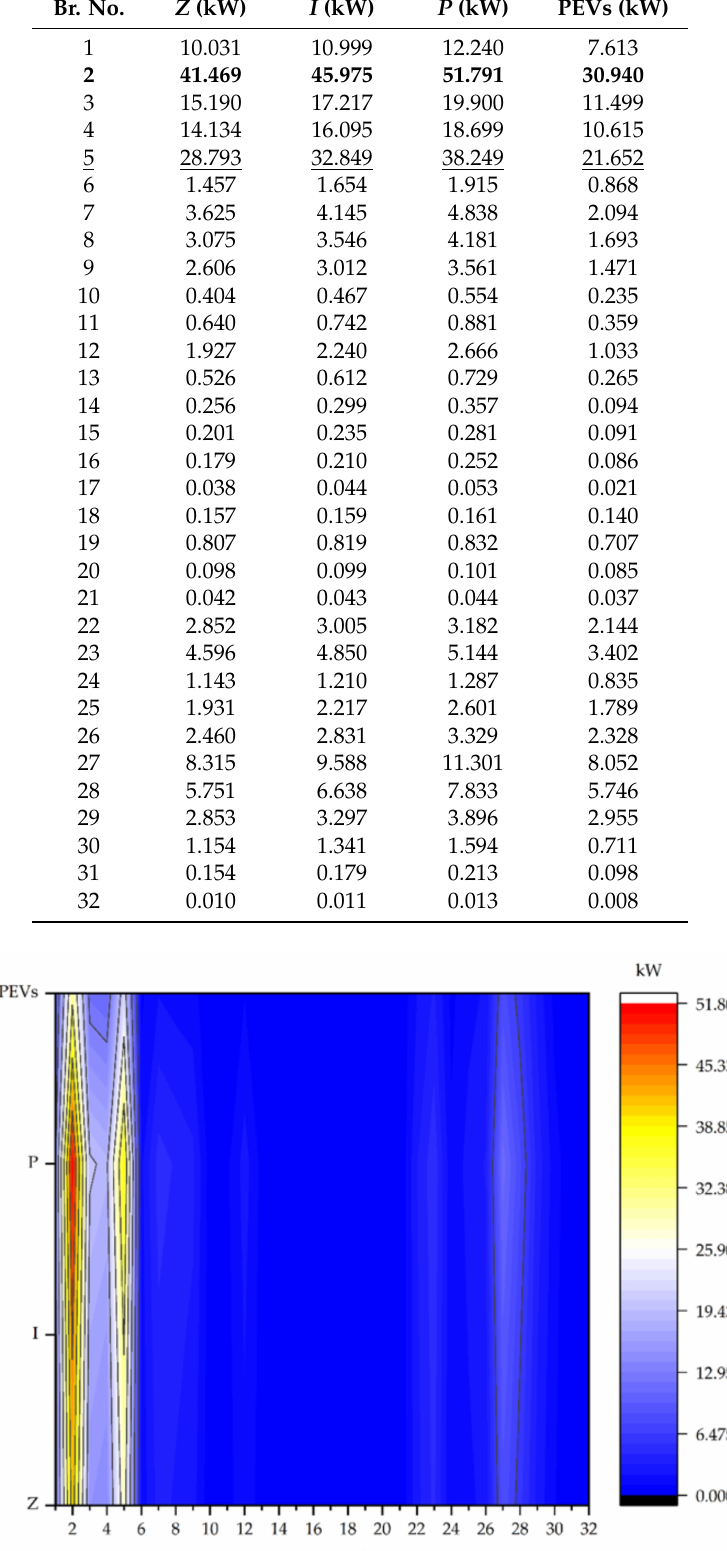
Table 6. Comparison of the 33 bus test system from the lines active power loss results.